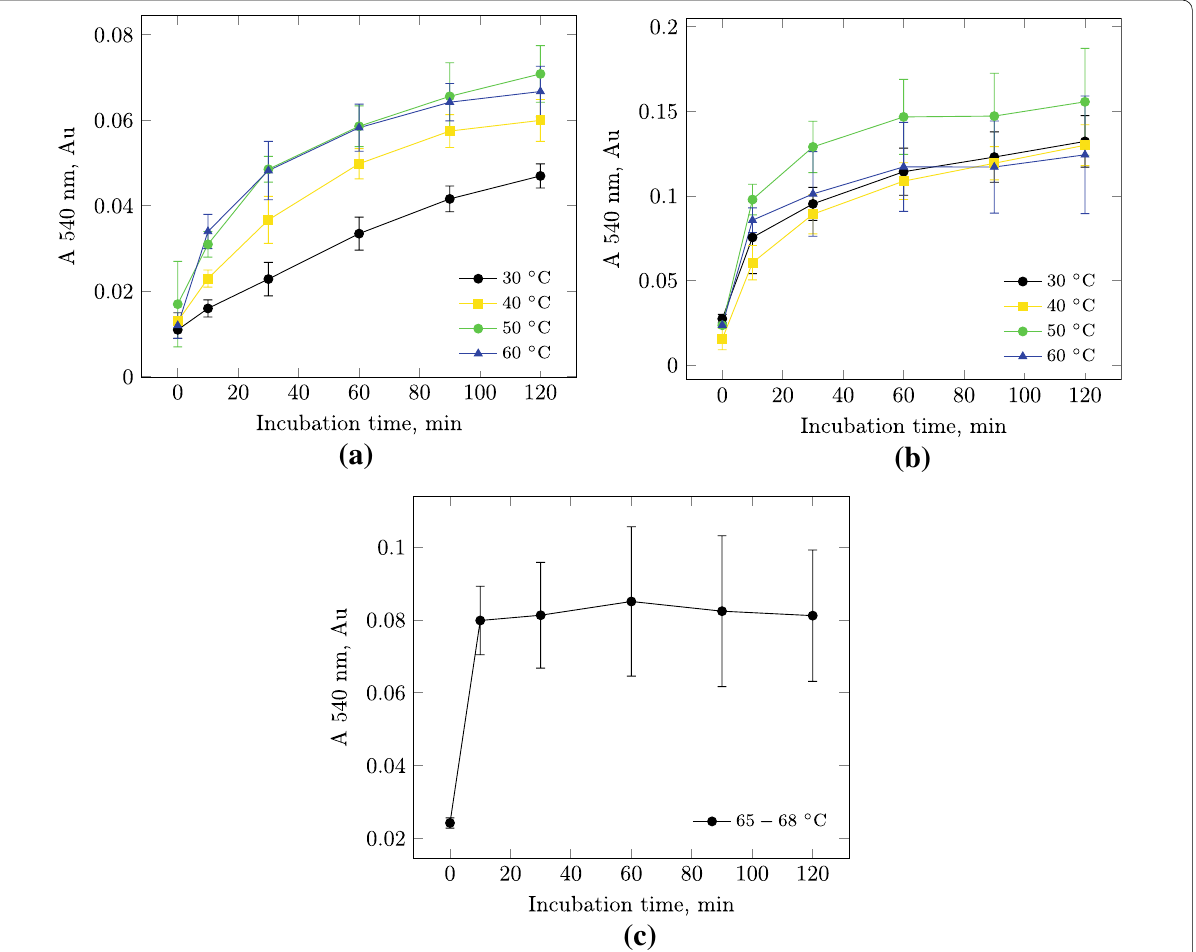
Fig. 4 Kinetic dependence of the accumulation of TCA-soluble peptides during the hydrolysis of soy protein isolate under the action of protosubtilin at different temperatures (the reaction mixture contained 6.7 units of proteolytic activity of PS per 1 g of SPI): a on a laboratory scale, b semi-industrial scale, c semi-industrial scale at 65–68 ◦